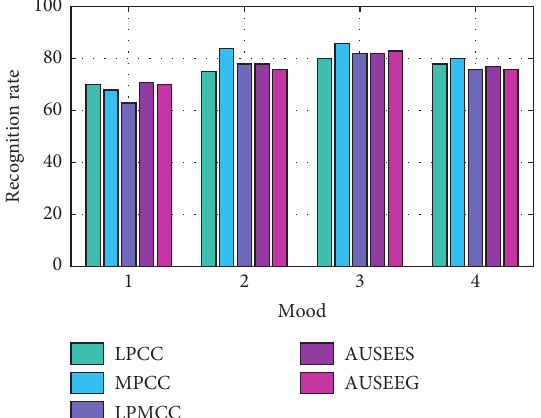
Figure 7: Comparison of recognition rates of different features under different emotions.